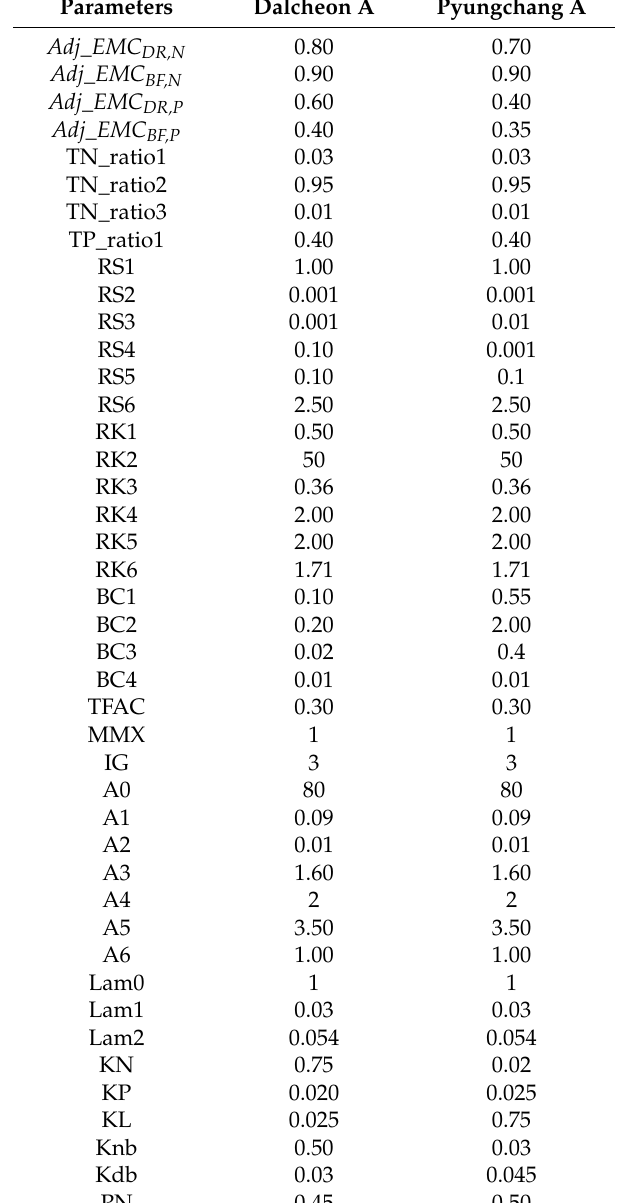
Table 6. Calibration parameters for the water quality component of the L-THIA ACN-WQ model. Parameters Dalcheon